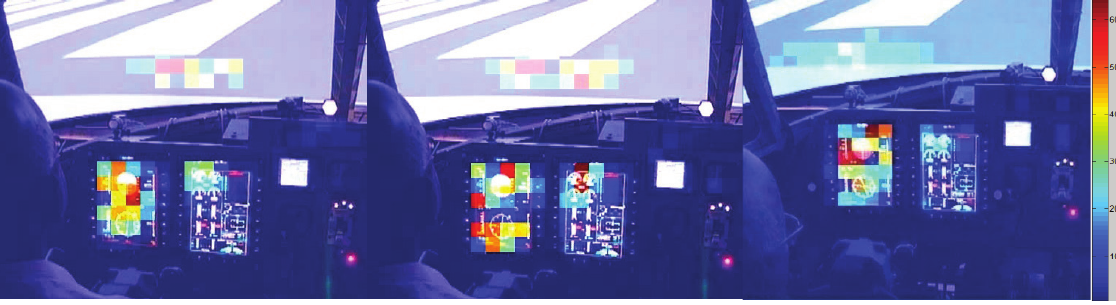
Figure 6. Mean Fixation